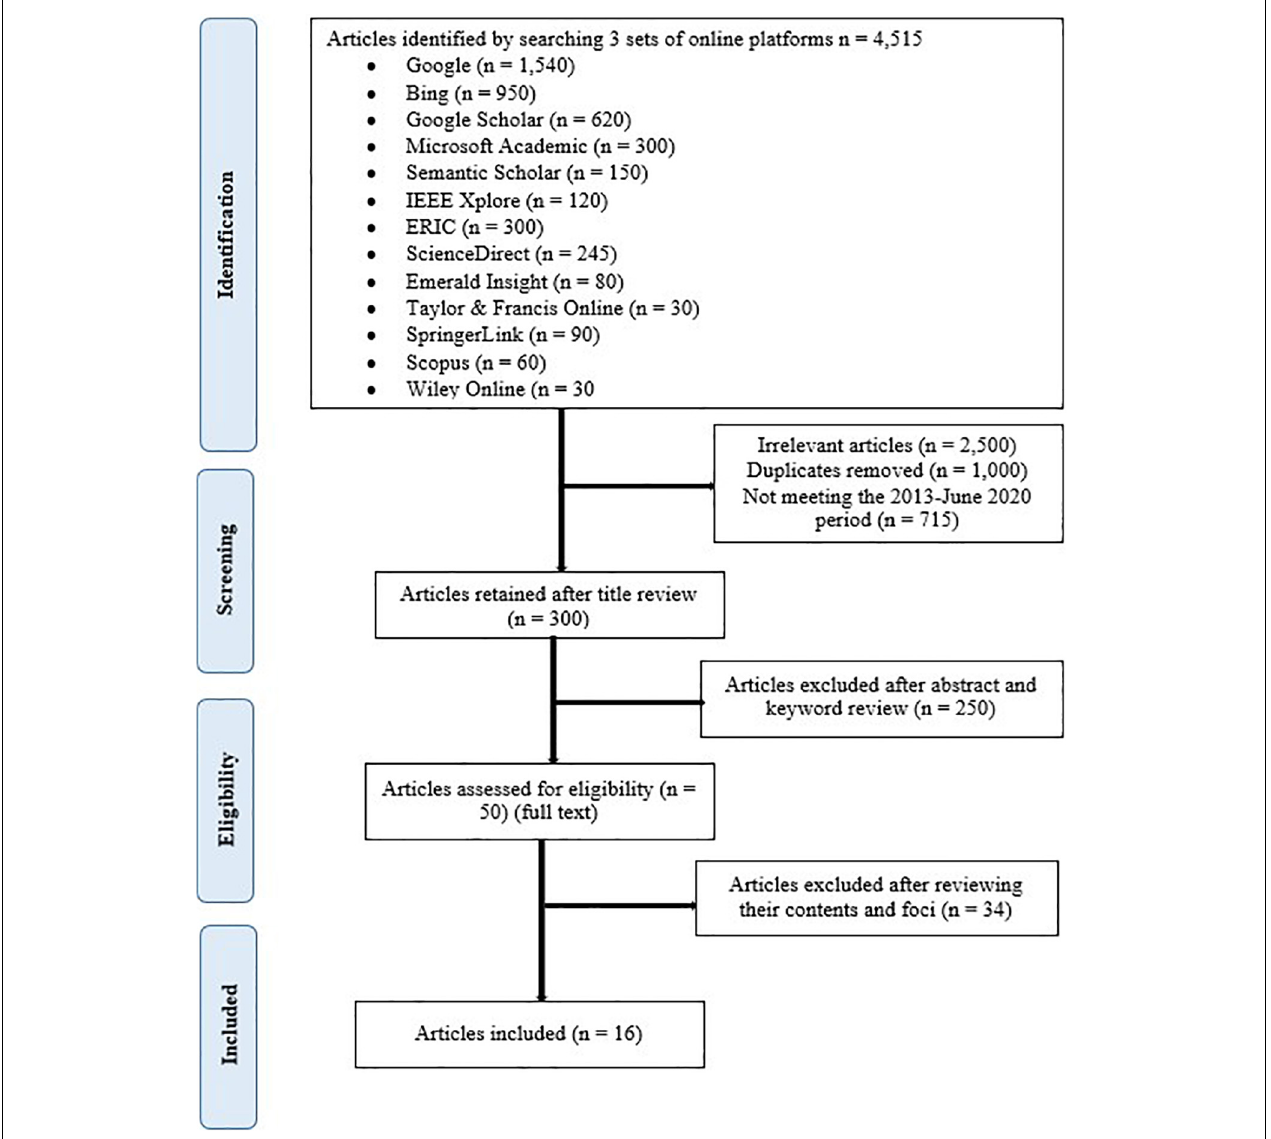
FIGURE 1 | The PRISMA flow chart and the online search